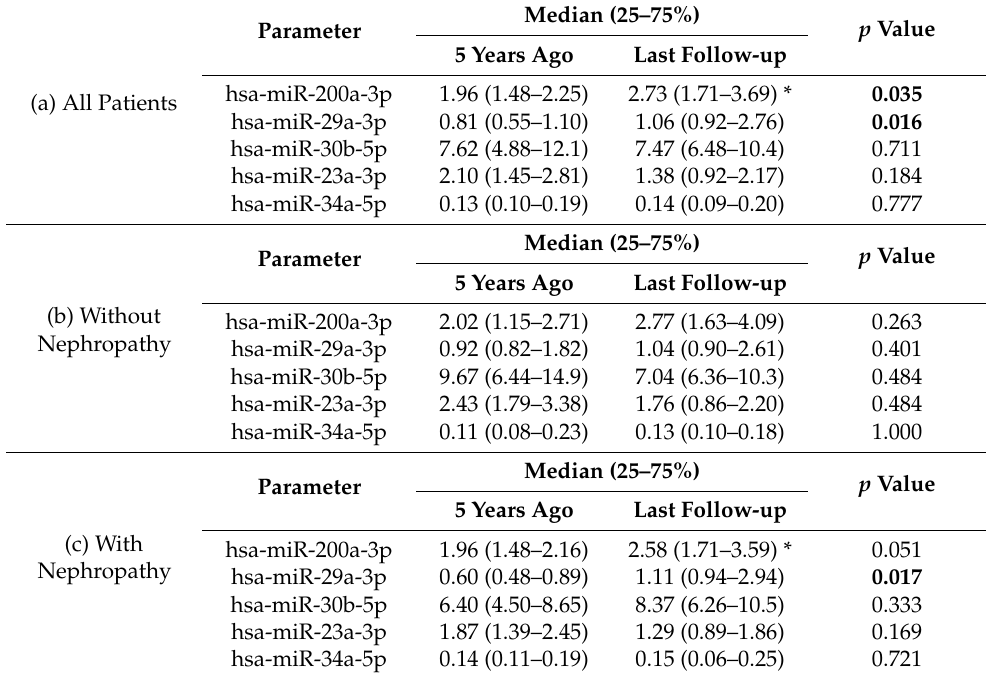
Table 7. Fold changes in the expression of miRNAs in (a) all patients ( n = 18), (b) patients with- out nephropathy ( n = 8), and (c) patients with Fabry nephropathy ( n = 10) in samples collected approximately 5 years apart.